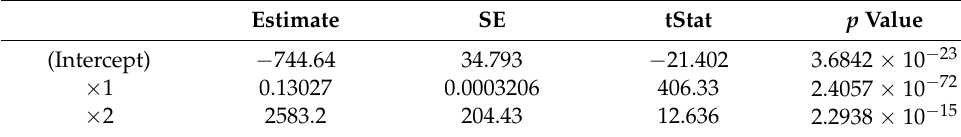
Table 1. Results from linear regression with PCA for